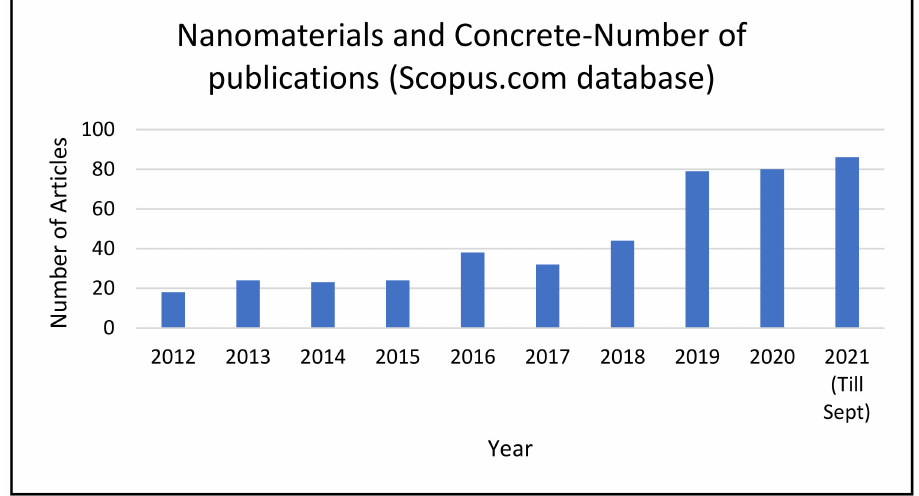
Figure 3. The number of articles (by year) in which ‘nanomaterials’ and ‘concrete’ were seen in